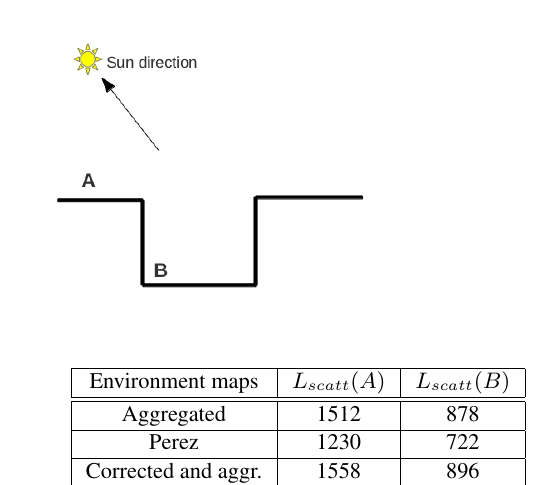
Figure 9: Comparison of the simulated radiance with different estimated environment maps. The radiance unit is arbitrary. using an estimated parametric model of blue sky for computing per-image corrections is proposed and reduces slightly the visual artifacts. Anyway, the influence of the errors of the environment map are small on the total simulated signal. The detection of sky pixels with colorimetric thresholds is not perfect; it could be enhanced by using LIDAR data when they are available with the acquired images, or simply by using a 3D model and a tree detection. Another interesting improvement could come from exposure bracketing: the overexposed areas would be reduced, and the artifacts could me more easily avoided as they depend on the